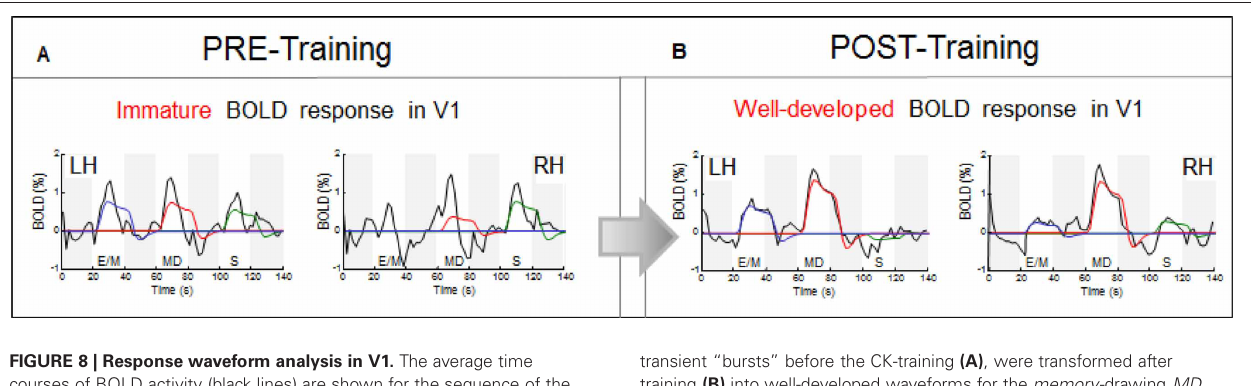
transient “bursts” before the CK-training (A) , were transformed after training (B) into well-developed waveforms for the memory -drawing MD , in contrast to the loss of any significant response for the non-memory drawing S